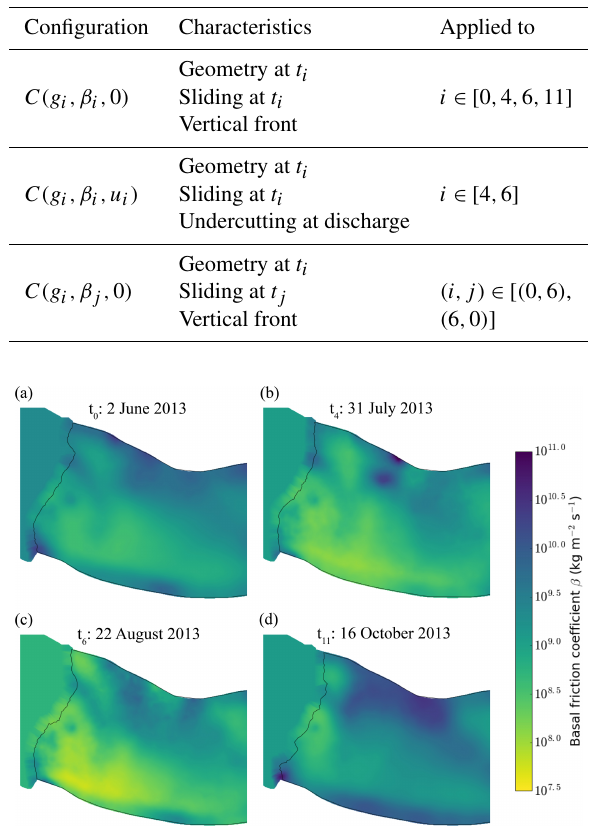
Figure 5. Basal friction coefficient obtained from inverse mod- elling and observed frontal position for (a) t 0 : 2 June 2013, (b) t 4 : 31 July 2013, (c) t 6 : 22 August 2013 and, (d) t 11 : 16 October